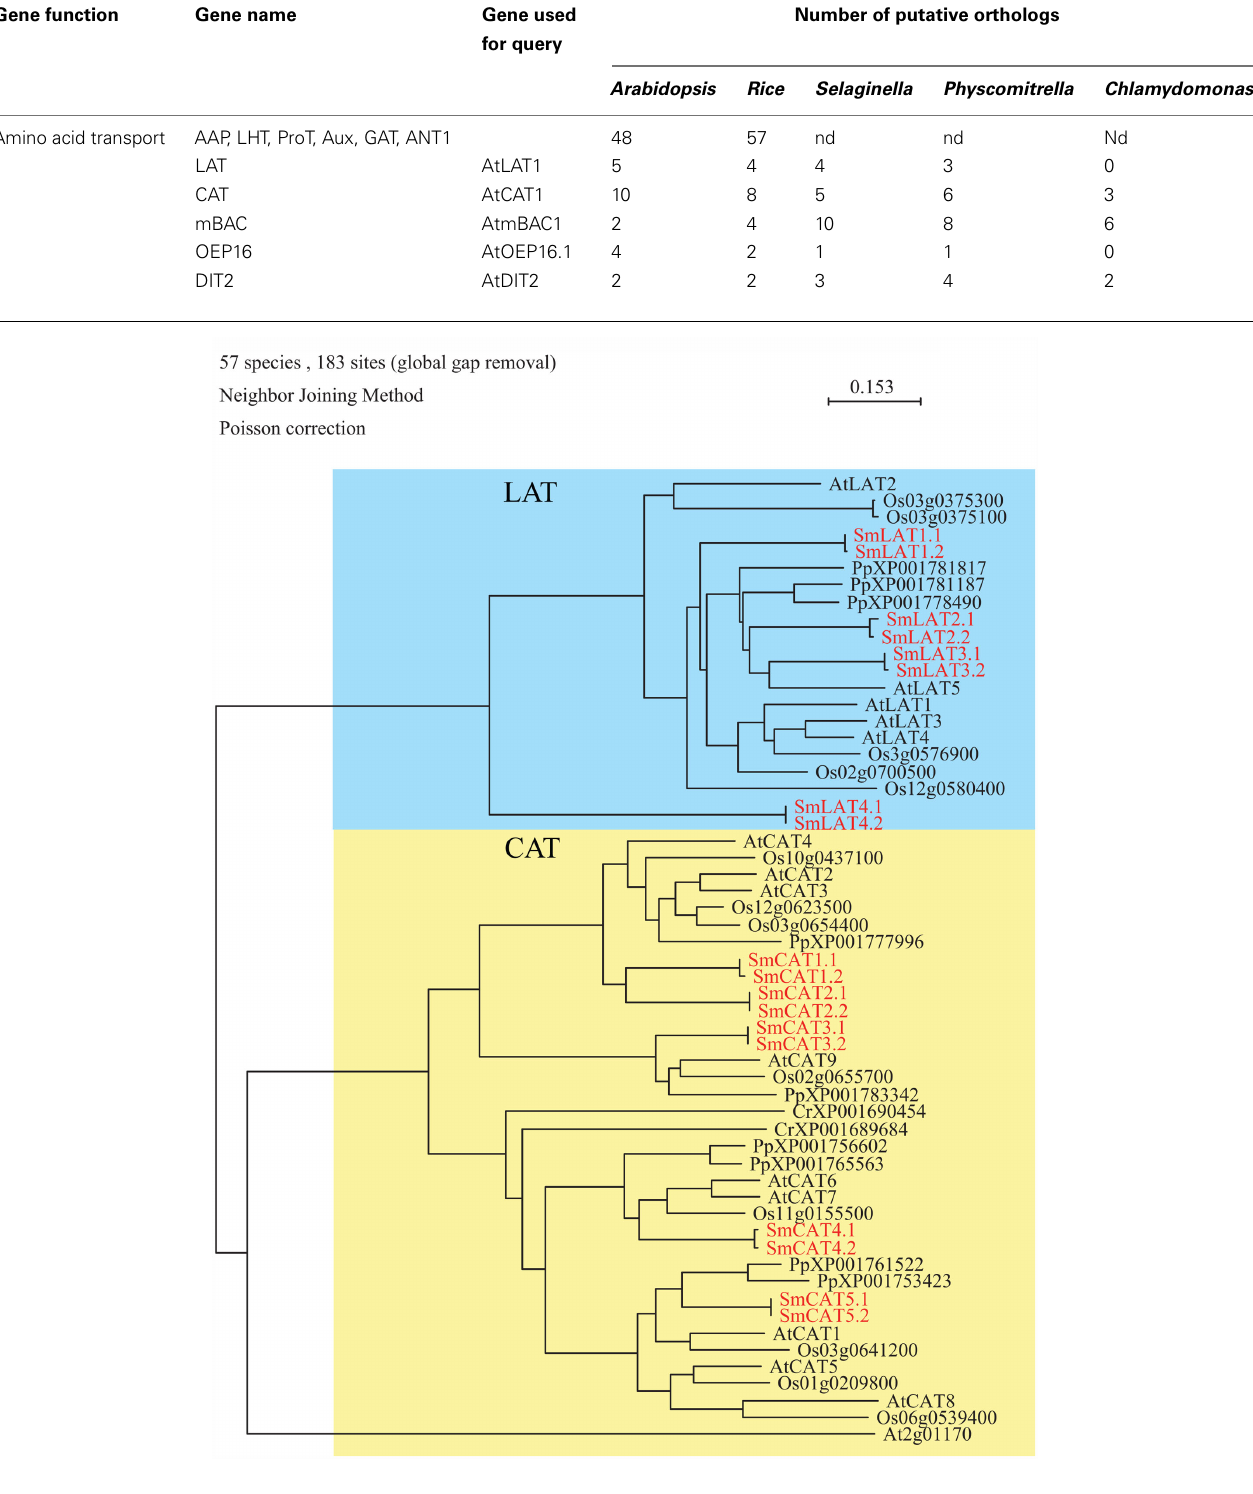
FIGURE 1 | Phylogenetic tree of amino acid polyamine choline (APC) superfamily transporters. The alignment was obtained from ClustalW and tree was build using PAUP software. At, Arabidopsis thaliana ; Cr,